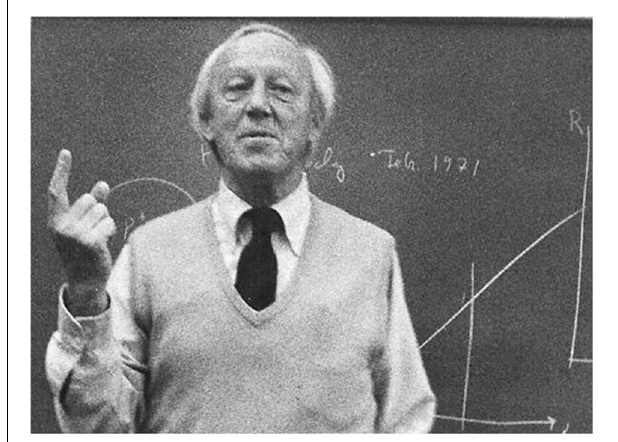
FIGURE 2 | (A) The ultraviolet Sun. Credit: SoHO. (B) The X-ray Sun. Credit: